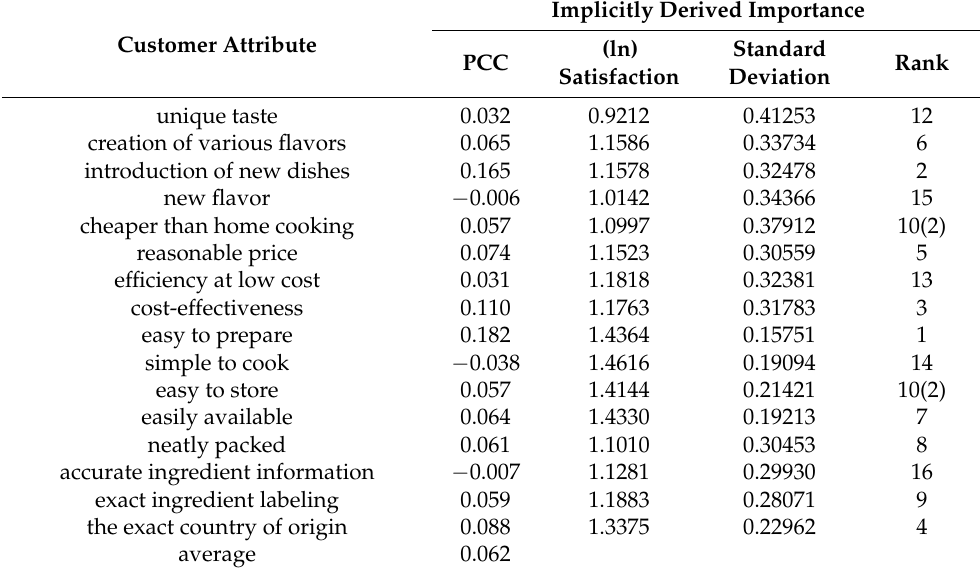
Table 5. Implicitly derived importance of HMR attributes.